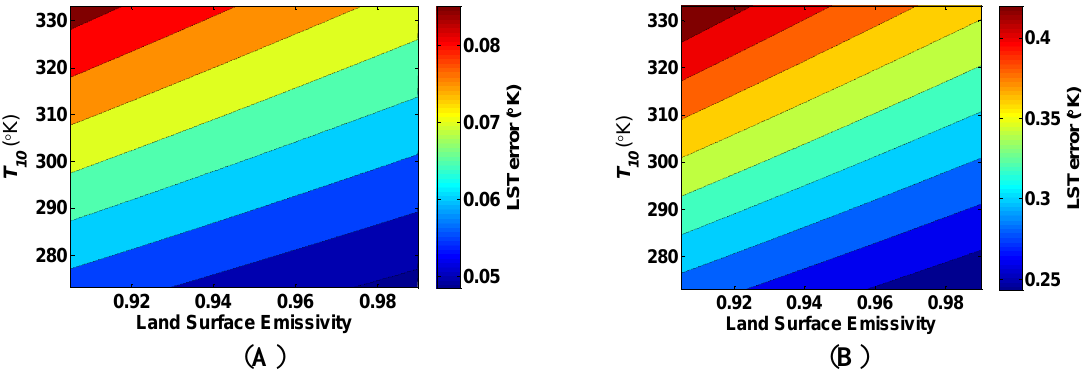
Figure 5. The increase in land surface temperature (LST) error (°K) as a result of underestimating the land surface emissivity (LSE) by ( A ) 0.001; and ( B ) 0.005, in both bands as a function of LSE and LST. T content is assumed to be 1.5 g · cm −2